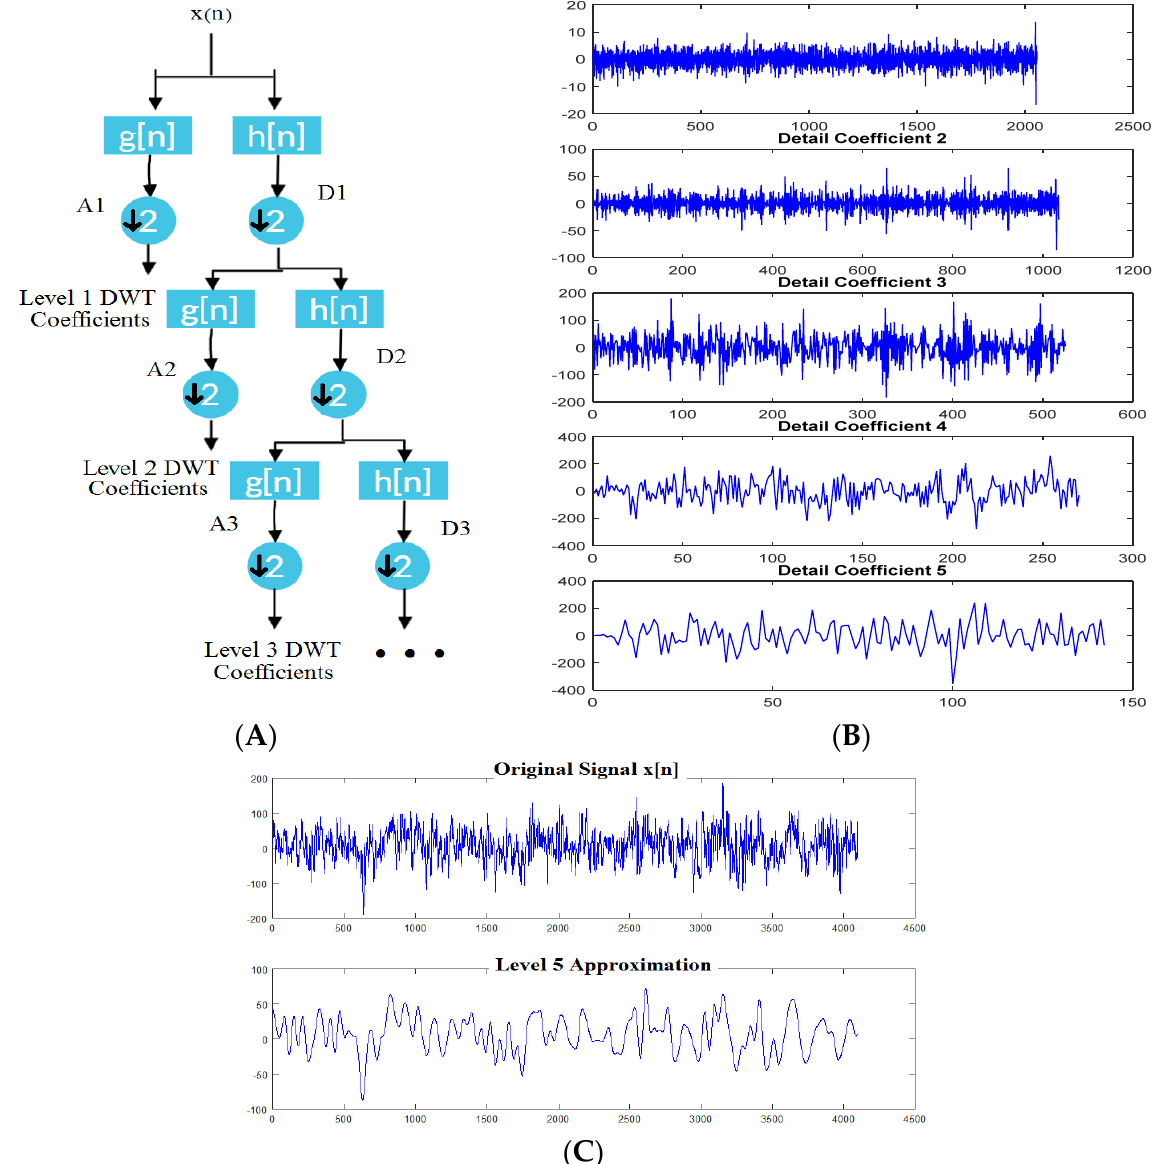
Figure 4. The wavelet decomposition method used to process a signal x(n). ( A ) Decomposition of a signal into its approximate (g(n)) and detail (h(n)) coefficients. ( B ) The signal decomposed into its five level detail coefficients. ( C ) Example of what a fifth level decomposition looks like.